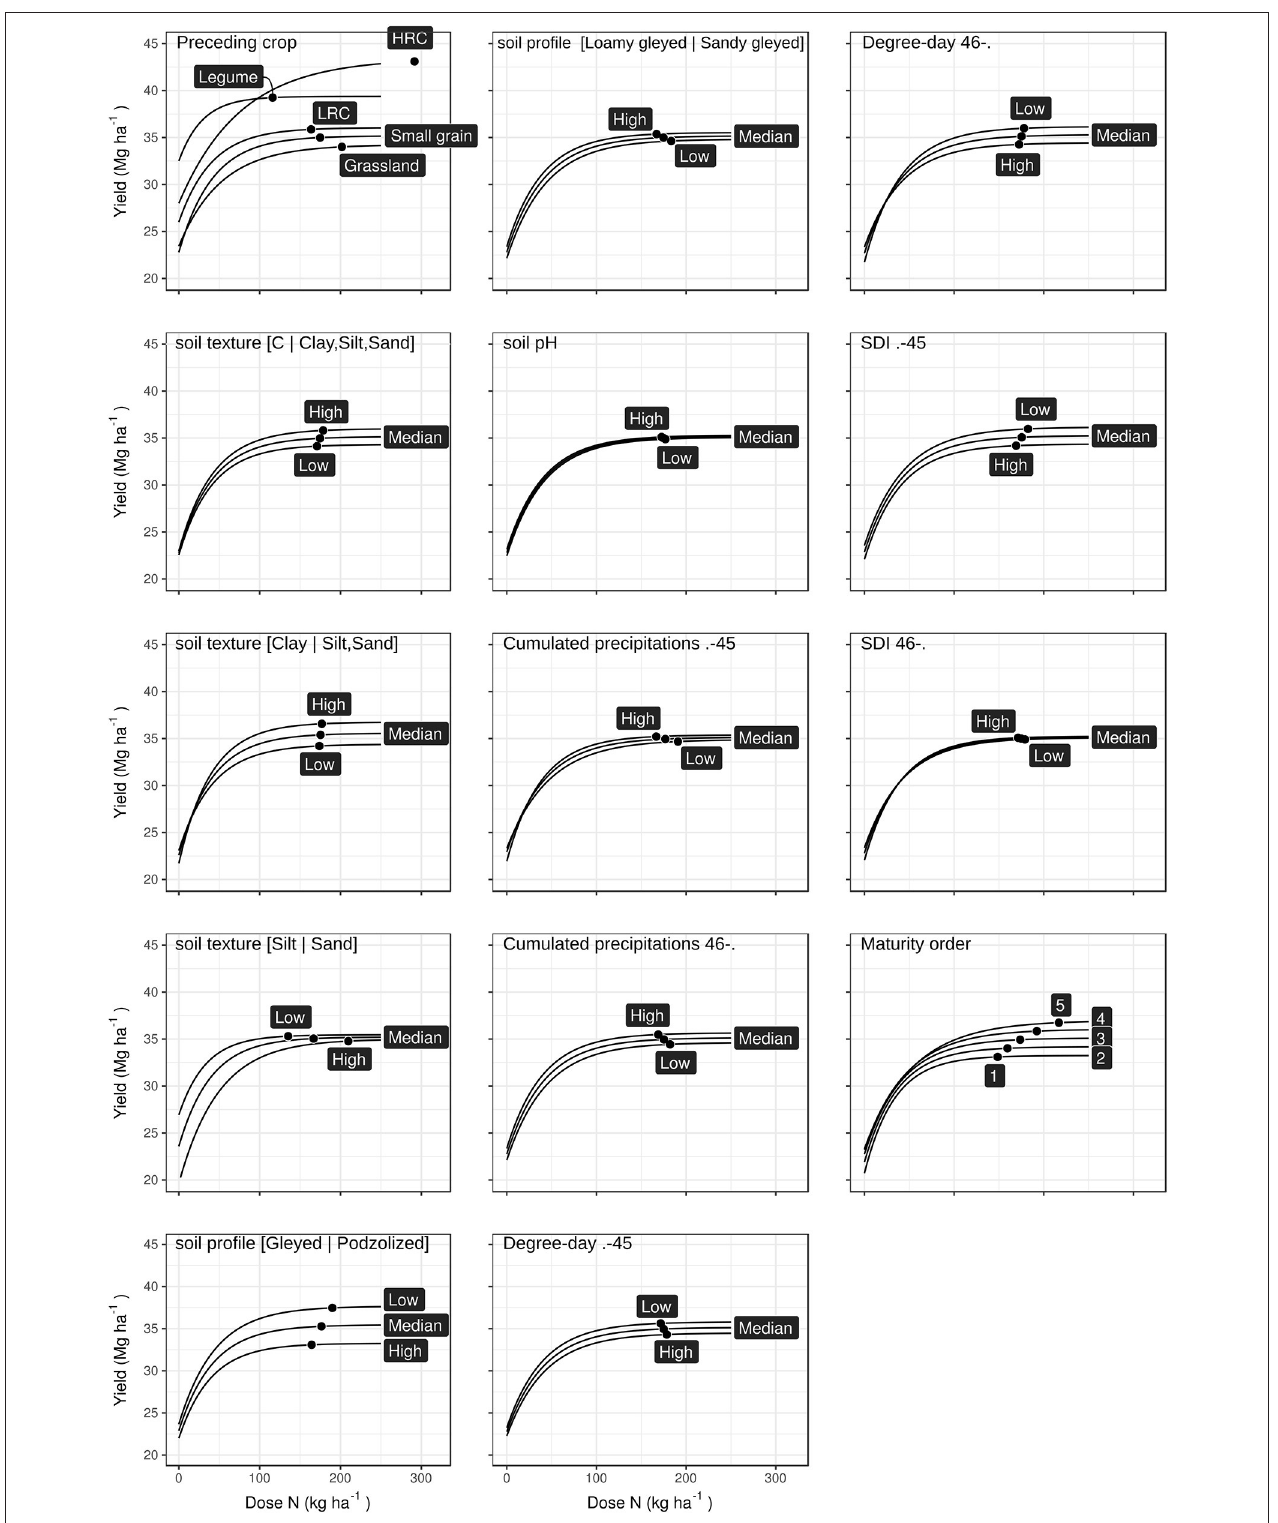
FIGURE 10 | Sensitivity of the multilevel mixed model. In each case, small grain was the preceding crop.